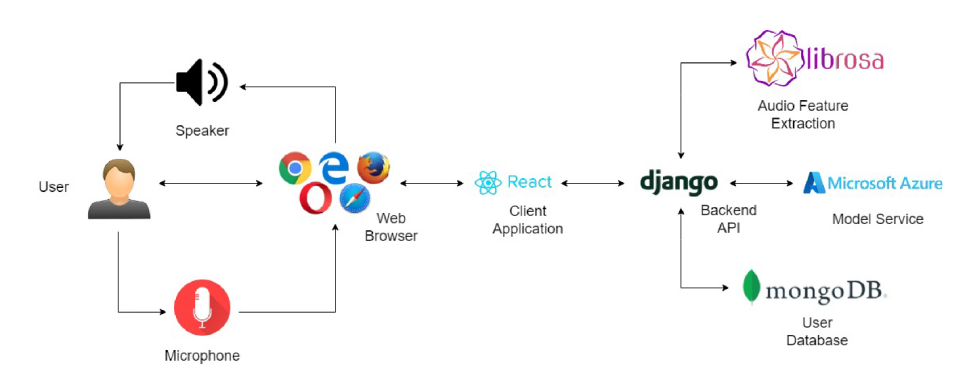
Figure 5. Architecture of the software application for aphasia classification and speech therapy recom-